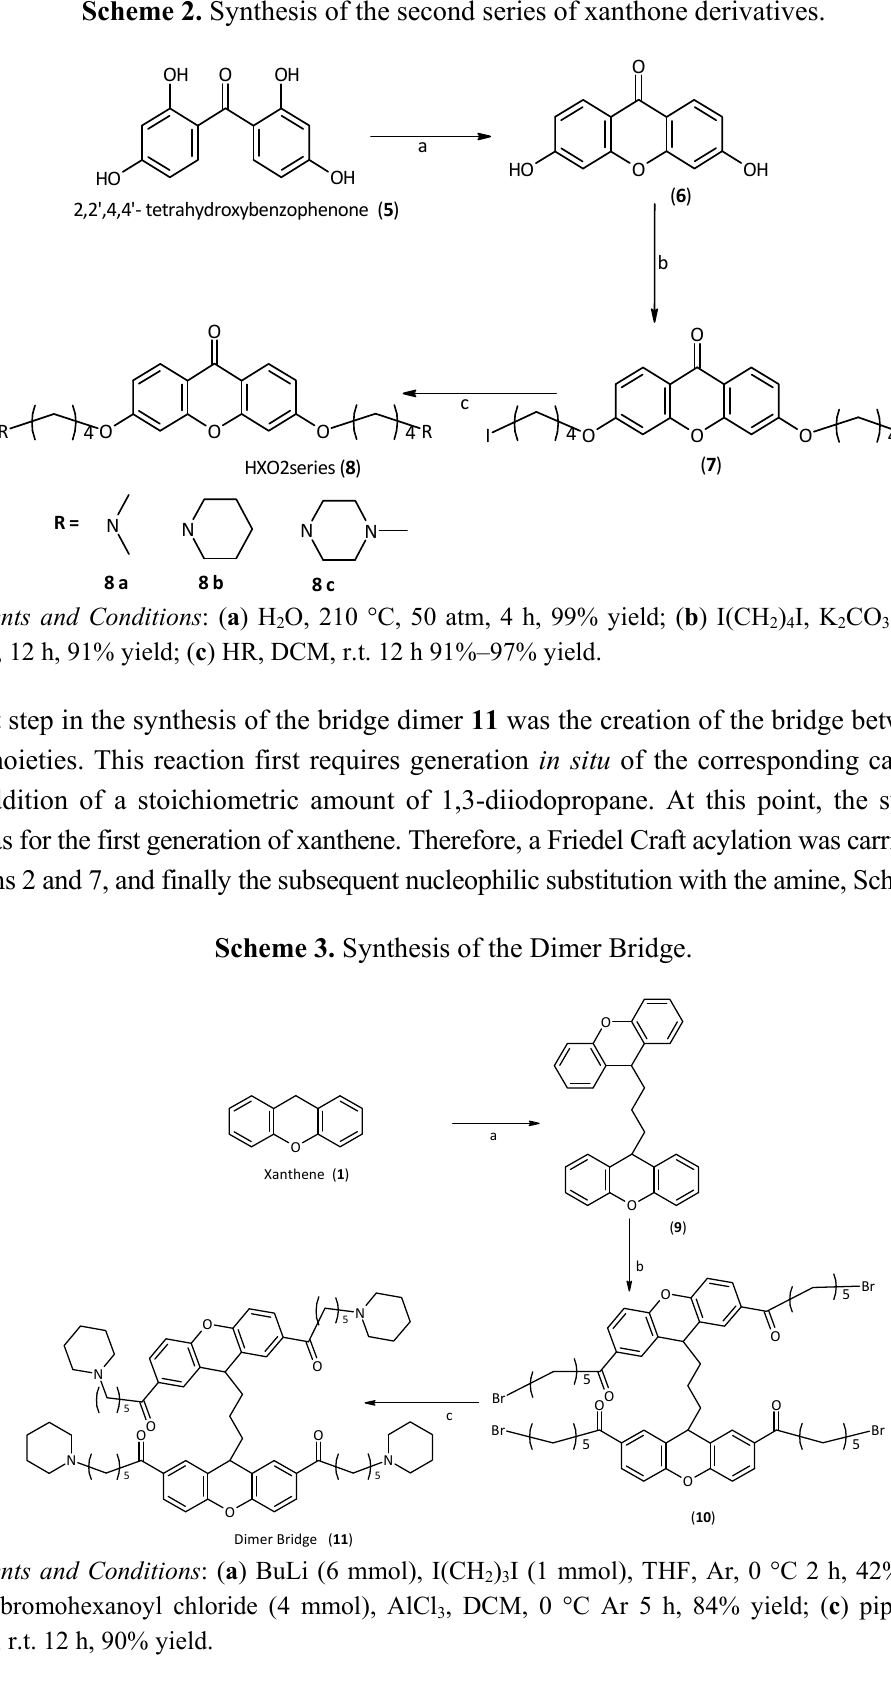
Scheme 2. Synthesis of the second series of xanthone derivatives.